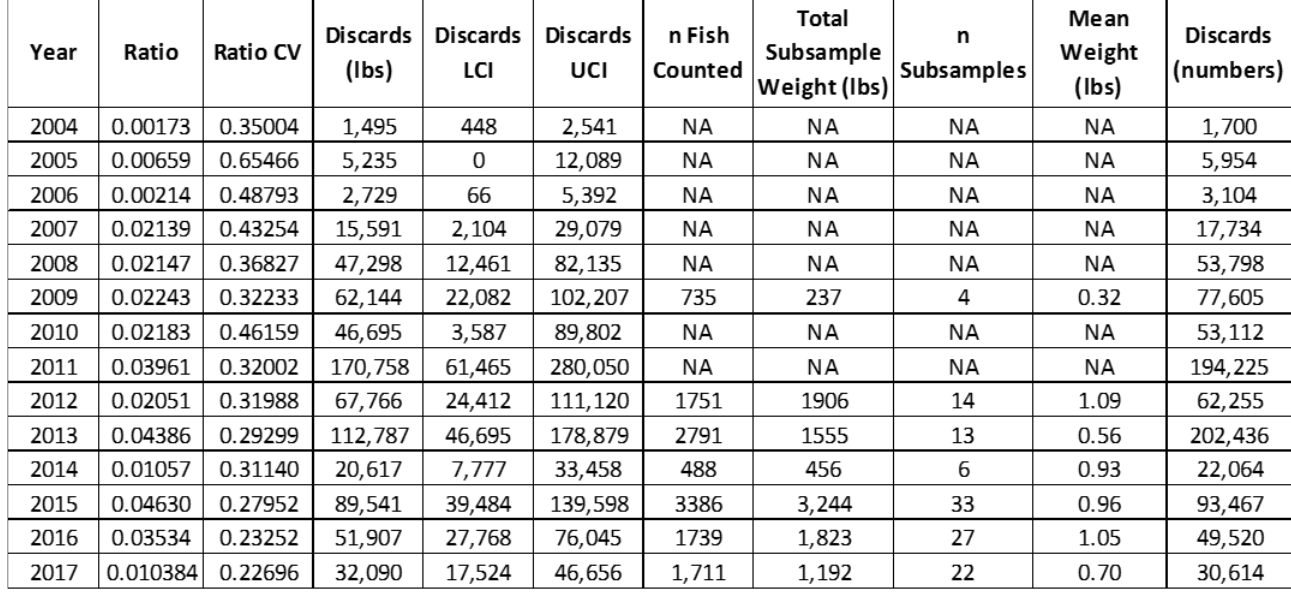
Table 32. Estimated horseshoe crab trawl discards in weight (lbs) and numbers. Year- specific data was used to convert weight to numbers for 2012-2016. For the remaining years, data was pooled among all years of available data for the